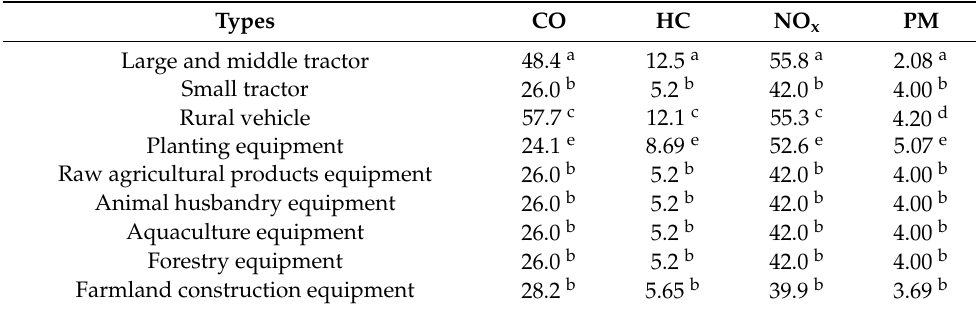
Table 5. Fuel-based emission factors of AM used in this study